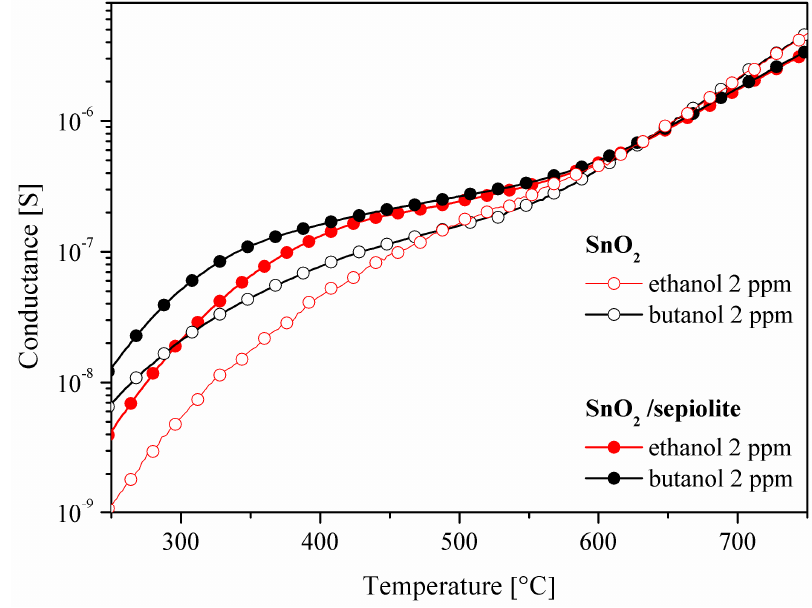
Figure 10. Temperature changes in the conductance of the SnO 2 sensor with and without the sepiolite filter in 2 ppm of ethanol or butanol.